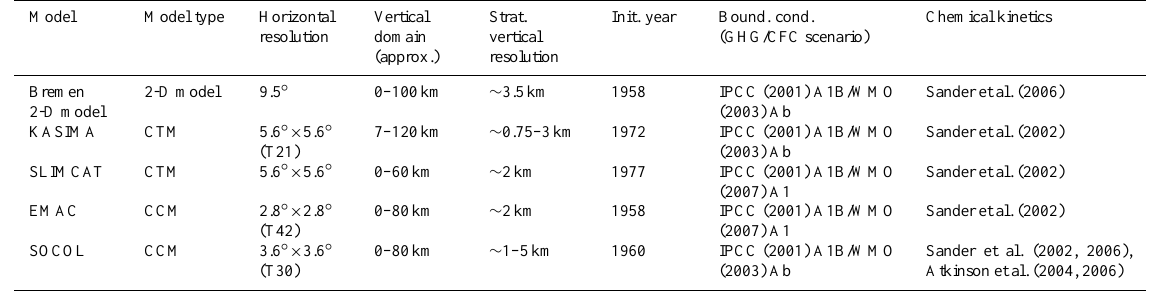
Table 2. Overview of the models. Please note that the vertical domains are pressure altitudes as most models operate on a pressure grid.